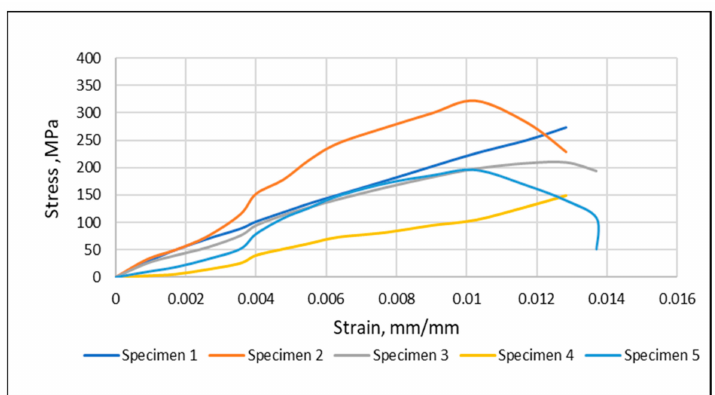
Figure 11. Tensile test result of five test specimens—32% volume fraction glass fiber.